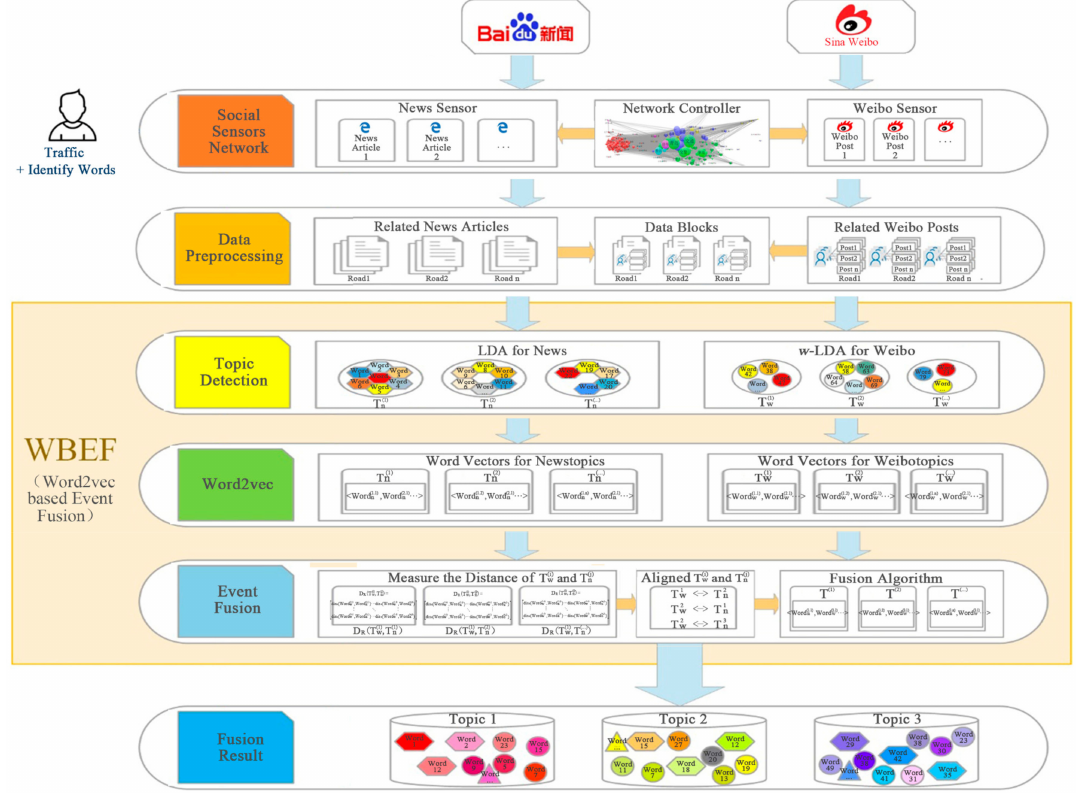
Figure 1. Architecture of cross-platform traffic event detection